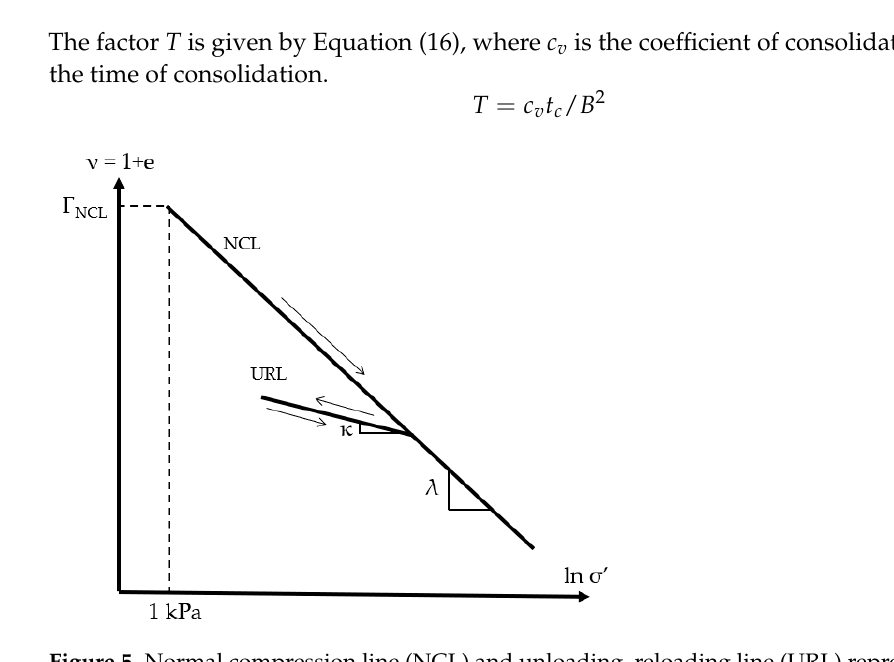
Figure 5. Normal compression line (NCL) and unloading–reloading line (URL) represented in the specific volume versus vertical effective stress plane.